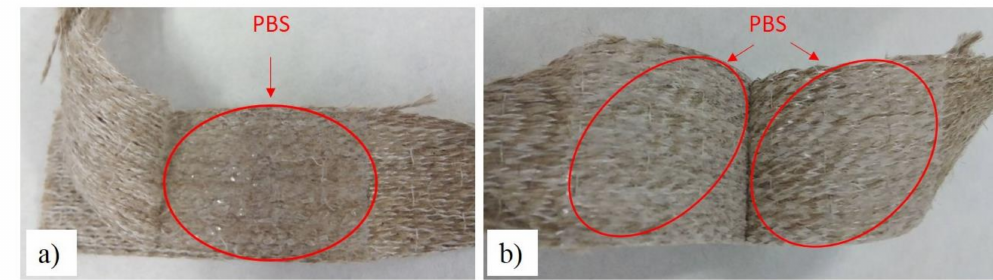
Figure 6. Failure types of PBS samples after peeling tests, ( a ) adhesive and ( b )